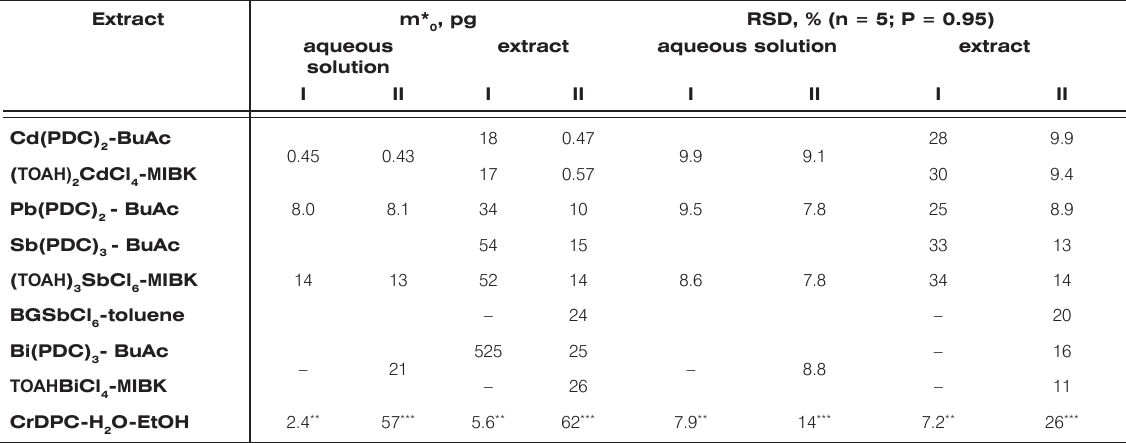
Table 2. Characteristic masses and relative standard deviation (RSD) in volatilization of aqueous solution and organic extracts from the furnace wall (I) and platform (II). Extract m* , 0